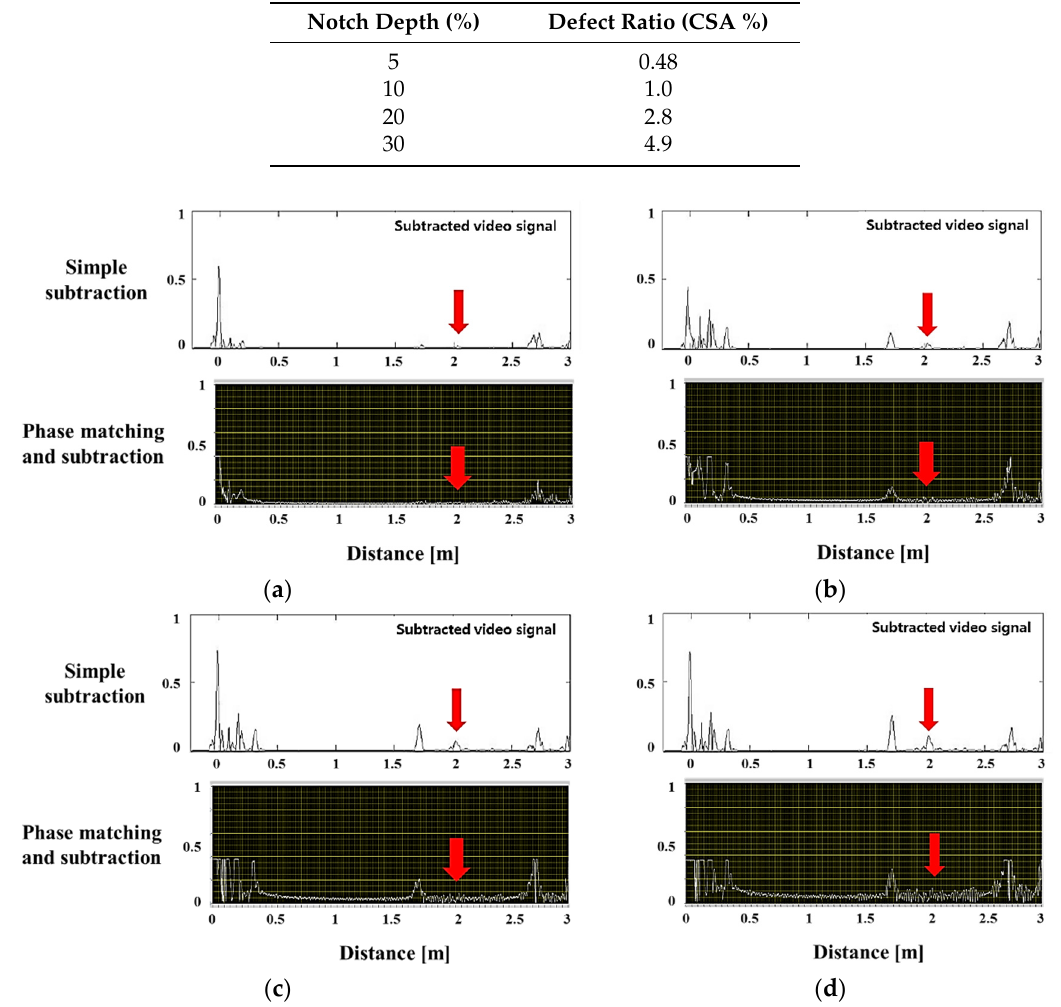
Figure 7. Subtraction between simple elimination, and phase matching-subtraction; signals of notches with various depths in a pipe weld: ( a ) 5%, ( b ) 10%, ( c ) 20% and ( d ) 30% of pipe wall thickness.